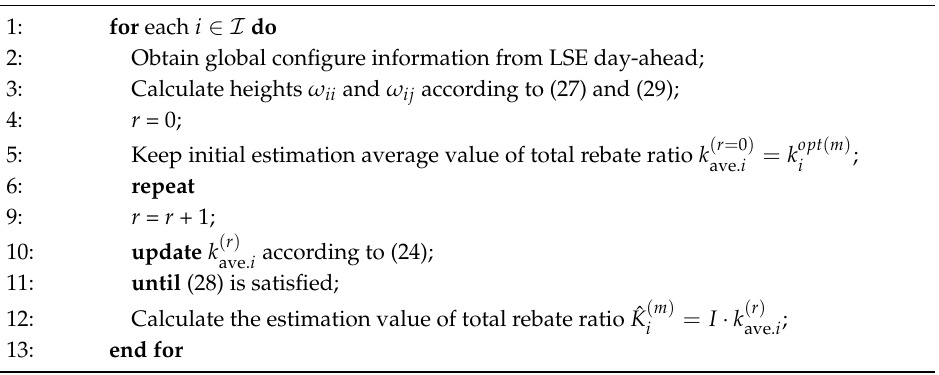
Algorithm 2: Gossip algorithm for each DR customer i ∈ I to estimate ˆ K